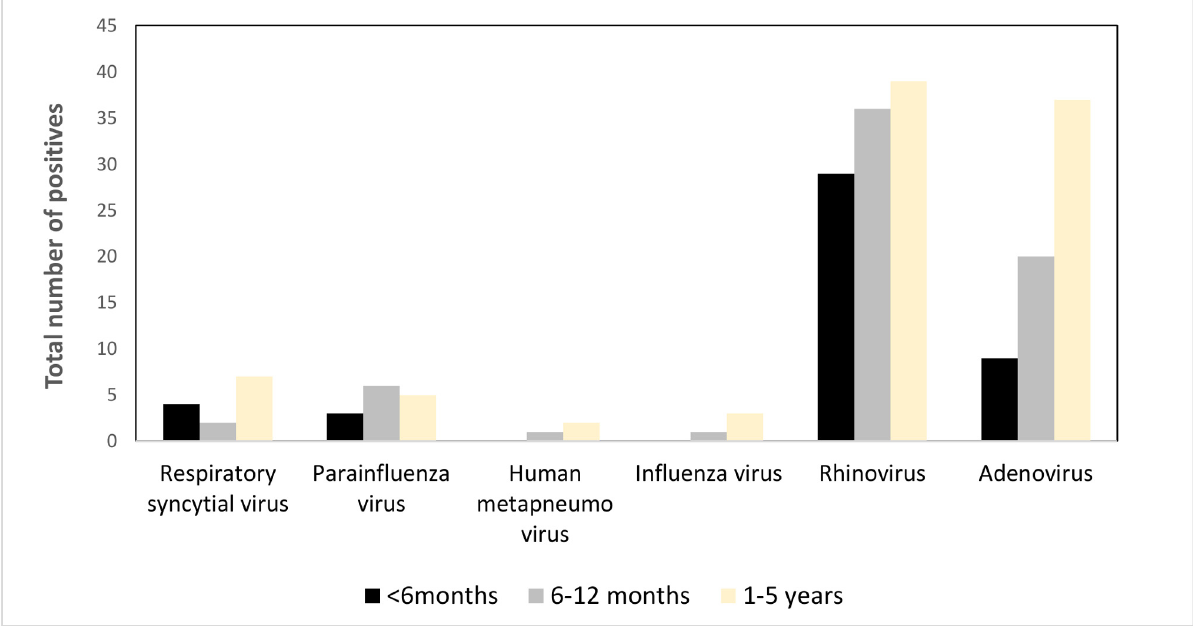
Fig 2. Cumulative age-specific viral etiology of hospitalized children without respiratory illness aged < 5 years enrolled in the four surveillance hospitals, Bangladesh, 2010 – 2014.